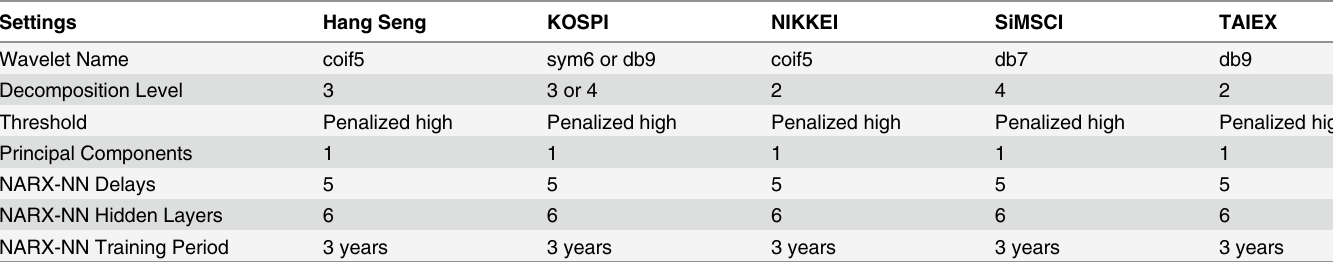
Table 2. Settings of the best-performing networks.